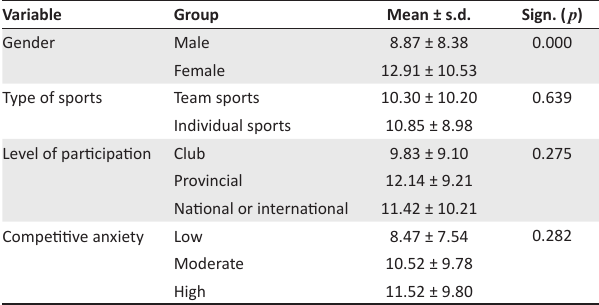
TABLE 4: Group differences for disordered eating among amateur athletes. Variable